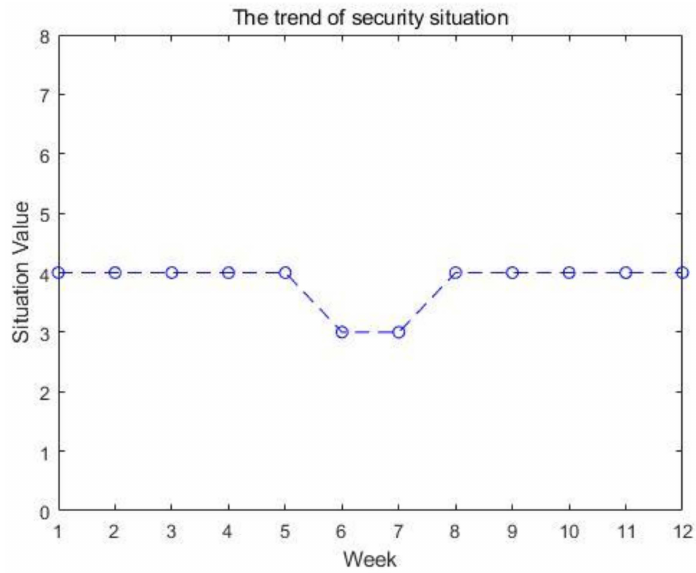
Figure 2. The trend of security